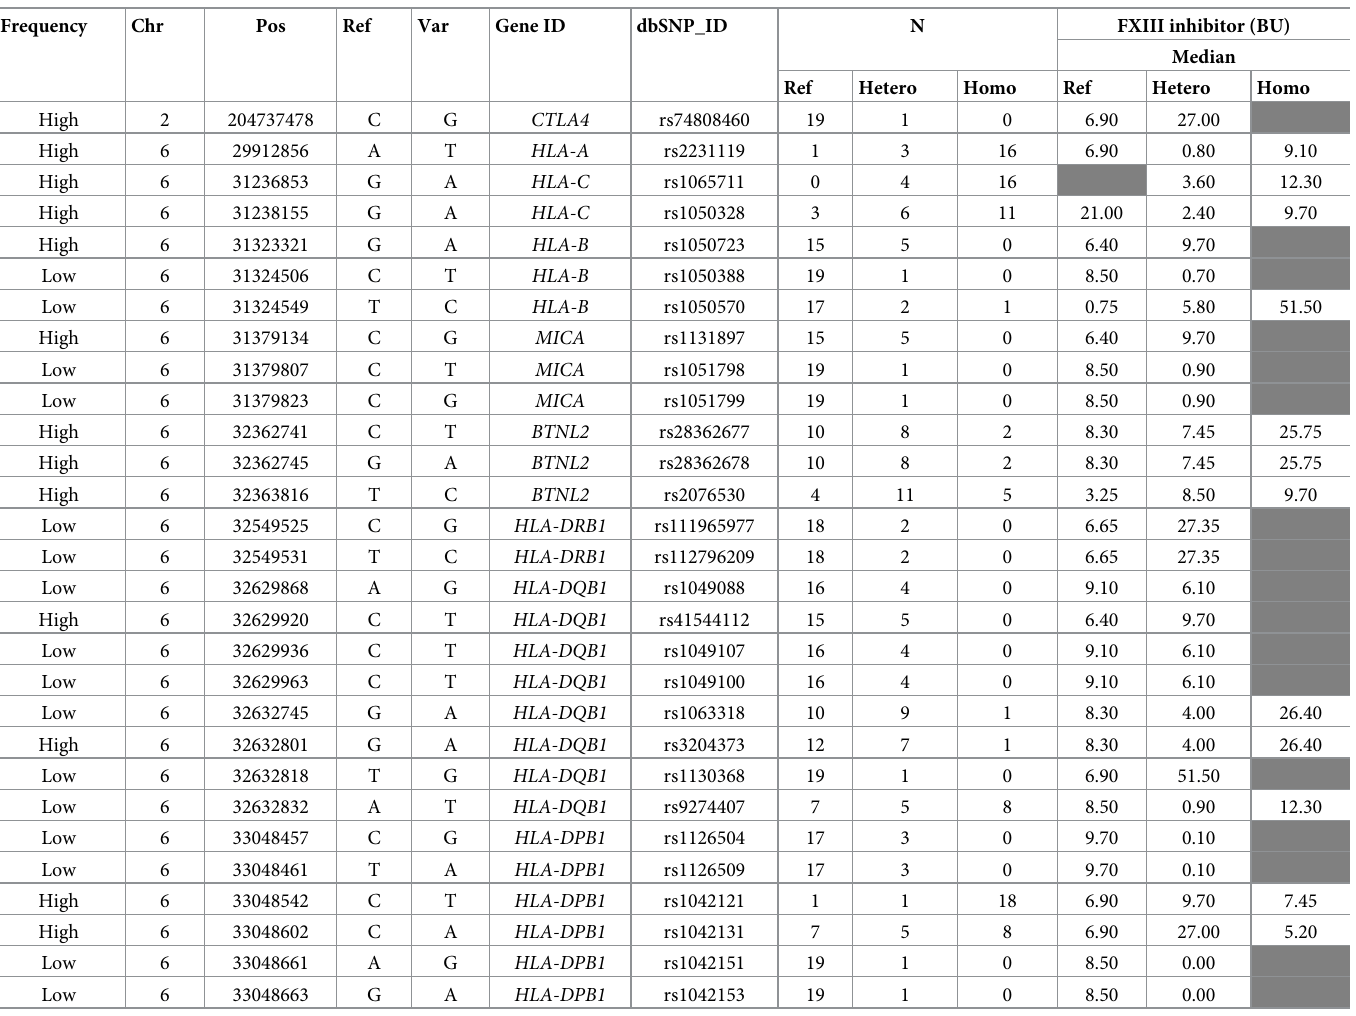
Table 3. FXIII inhibitors in each genotypes of MHC class I and II molecules and their associated